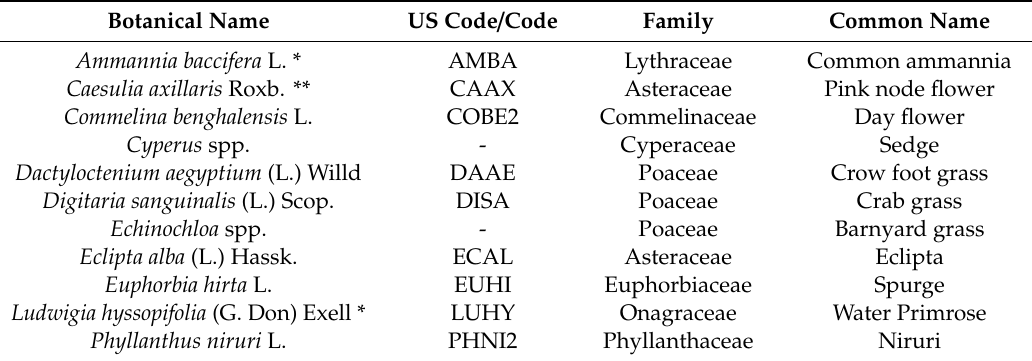
Table 3. Weed species recorded in the soil seed